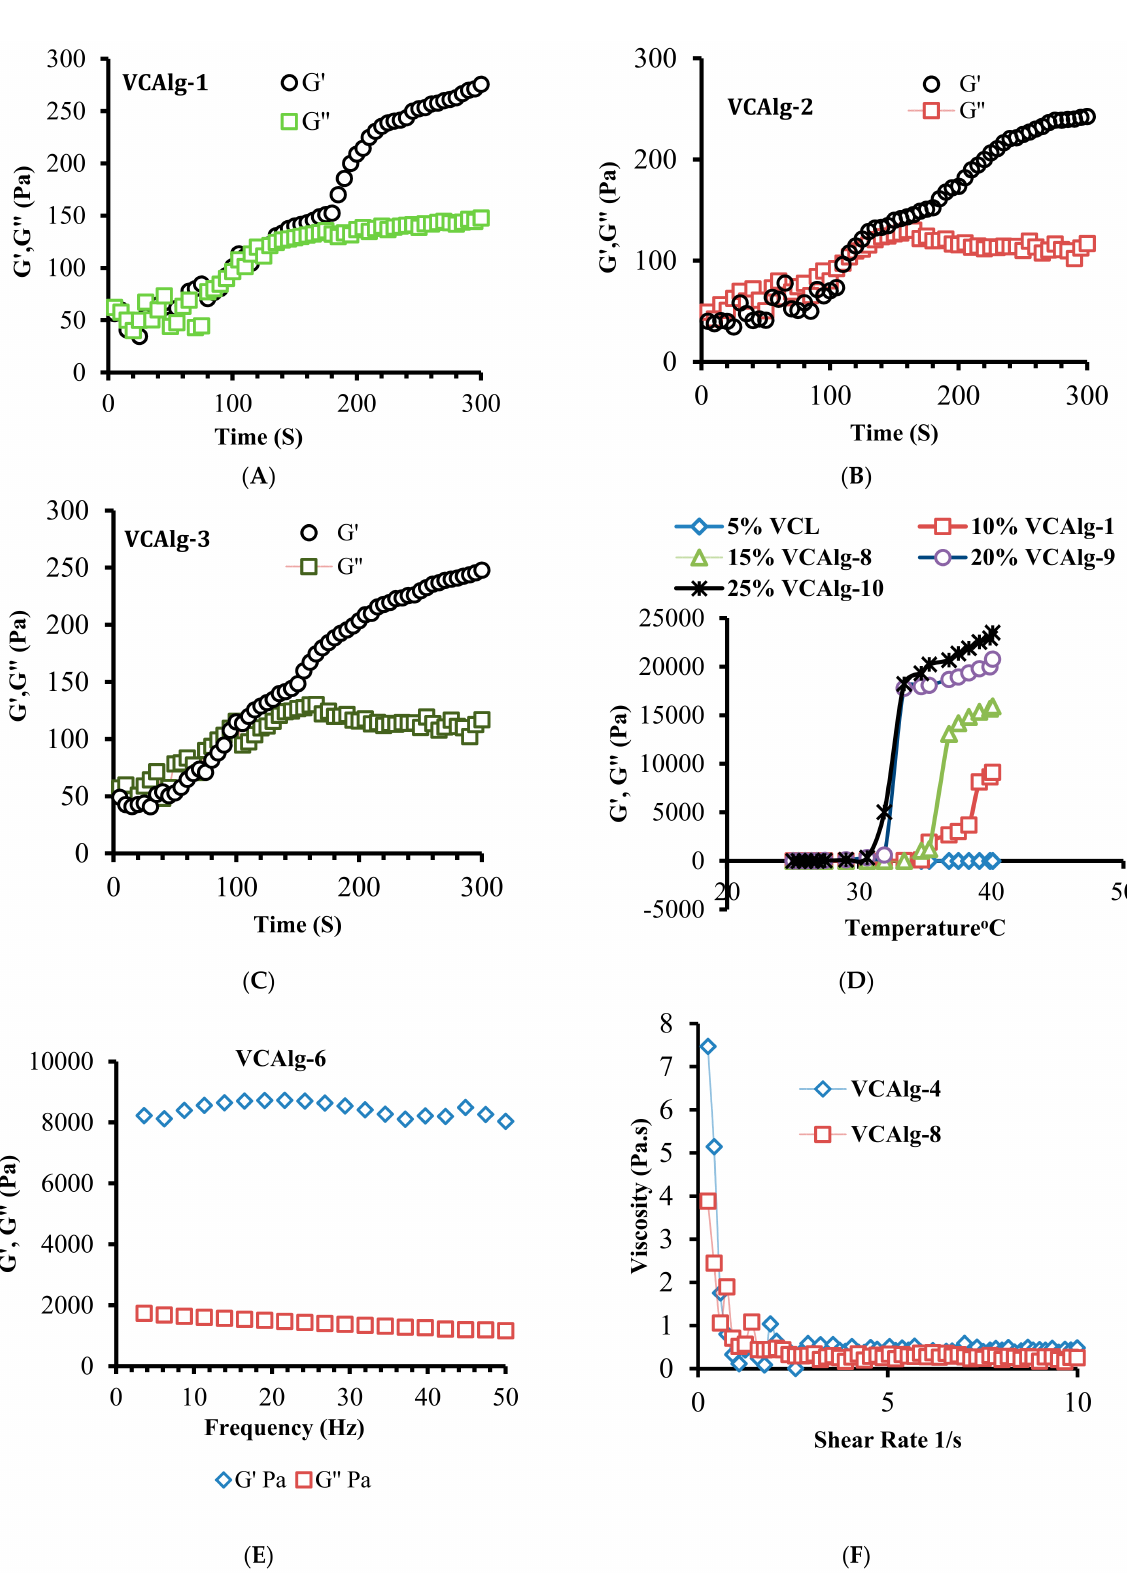
Figure 7. Oscillatory sweep tests and corresponding time data for depot gel formulations under strain = 1% and frequency = 1Hz ( A – C ). Change of G (cid:48) and G (cid:48)(cid:48) over 25 ◦ C to 40 ◦ C with increasing temperature for chemically grafted Poly (NVCL-g-NaAlg) depot gels ( D ). Frequency sweep test of thermoresponsive chemically grafted Poly (NVCL-g-NaAlg) depot gels under controlled strain of 1% ( E ). Effect of increasing shear rate (0.1–10 s − 1 ) on viscosity of gel formulations for 10 min at 25 ◦ C ( F ). All the experiments were conducted in triplicates (n =